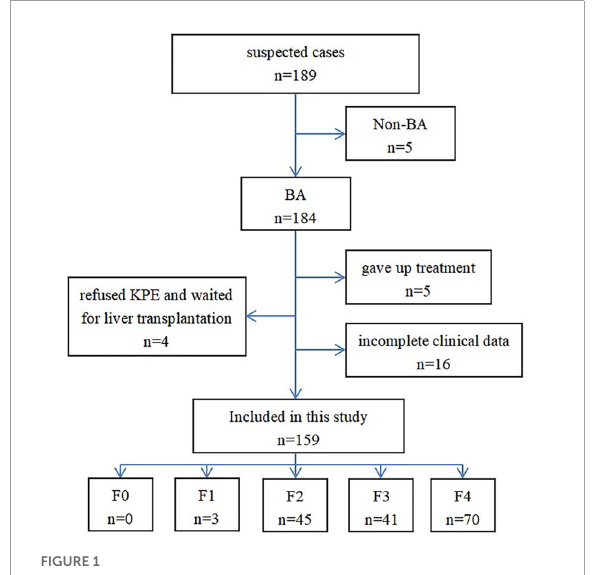
FIGURE1 Flow chart of case selection in this